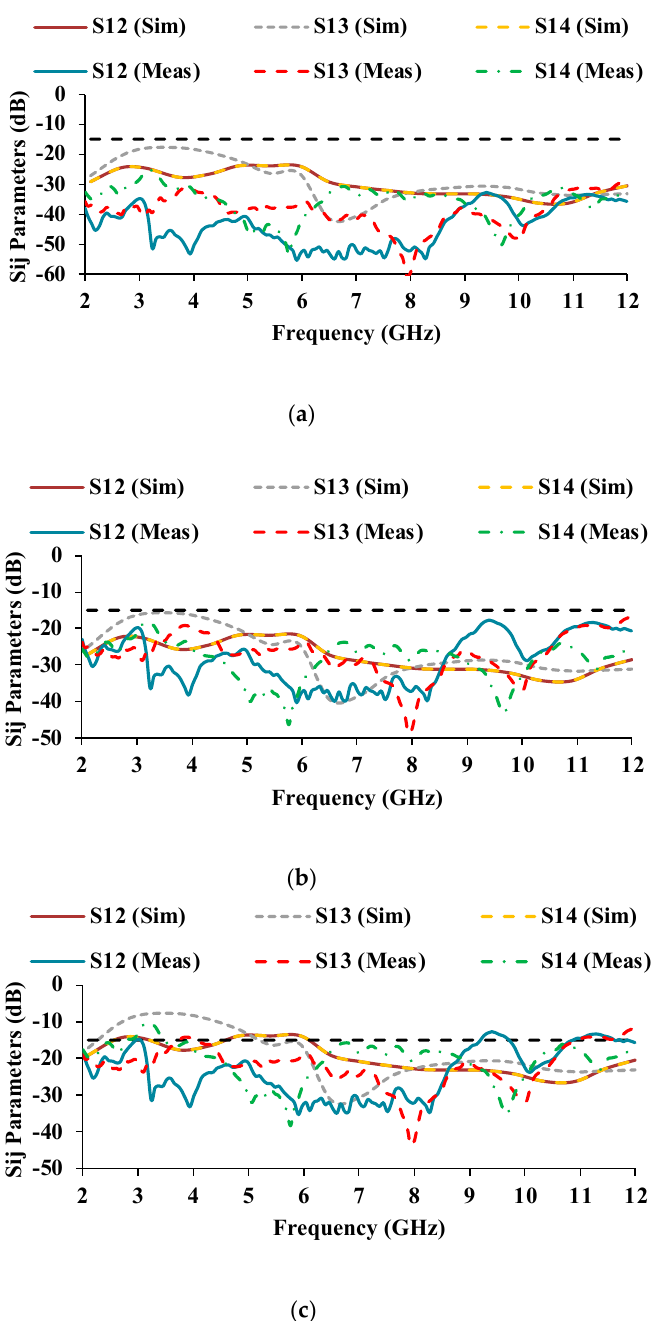
Figure 20. Transmission coefficients of the antenna at three bending radii ( a ) BR = 25 mm, ( b ) BR = 20 mm, ( c ) BR = 15 mm. Table 1. Bending angles at different bending radii.